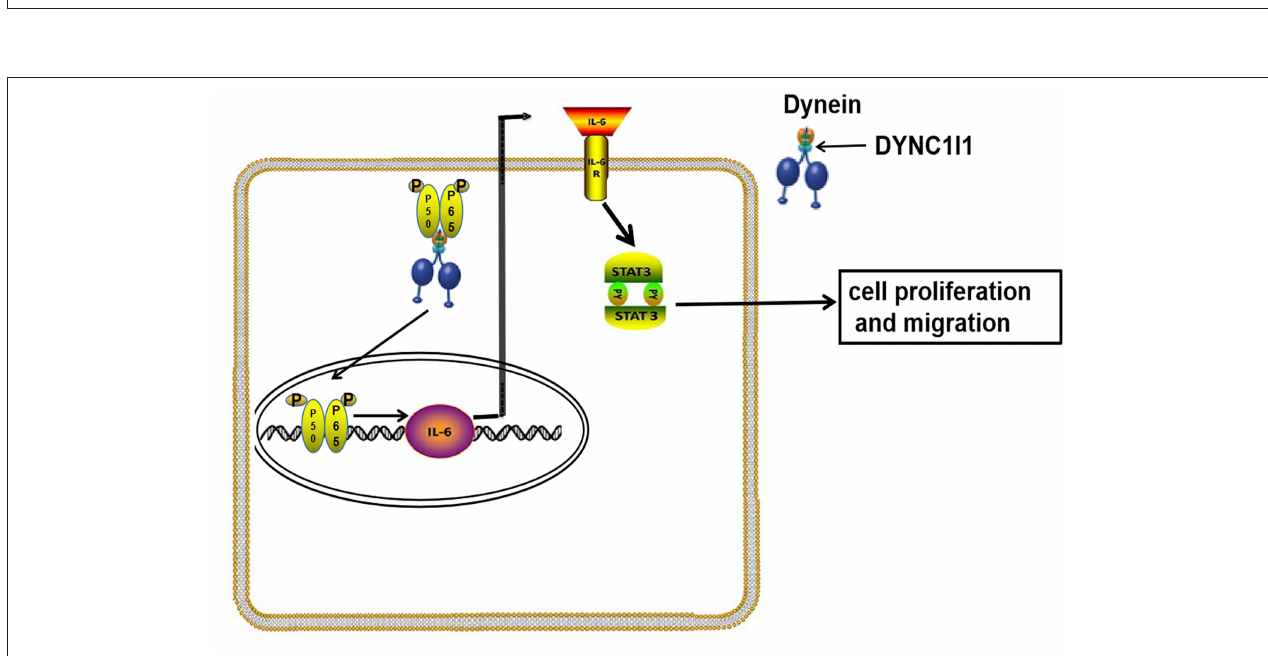
FIGURE 8 | Working model for DYNC1I1in gastric cancer cells. In gastric cancer cells, DYNC1I1 acts as a binding subunit of cytoplasmic dynein. P65 is transported to the nucleus by cytoplasmic dynein in combination with DYNC1I1. P65 entering the nucleus to promote IL-6 transcription. Up-regulated IL-6 promotes proliferation and metastasis of gastric cancer cells by up-regulating phosphorylated stat3.